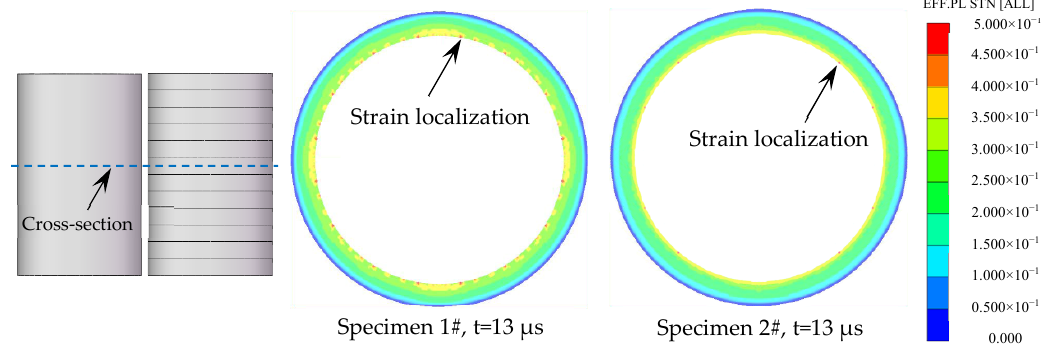
Figure 16. The e ff ective plastic strain of the representative cross-section of the specimens. Figure 16. The effective plastic strain of the representative cross-section of the specimens.